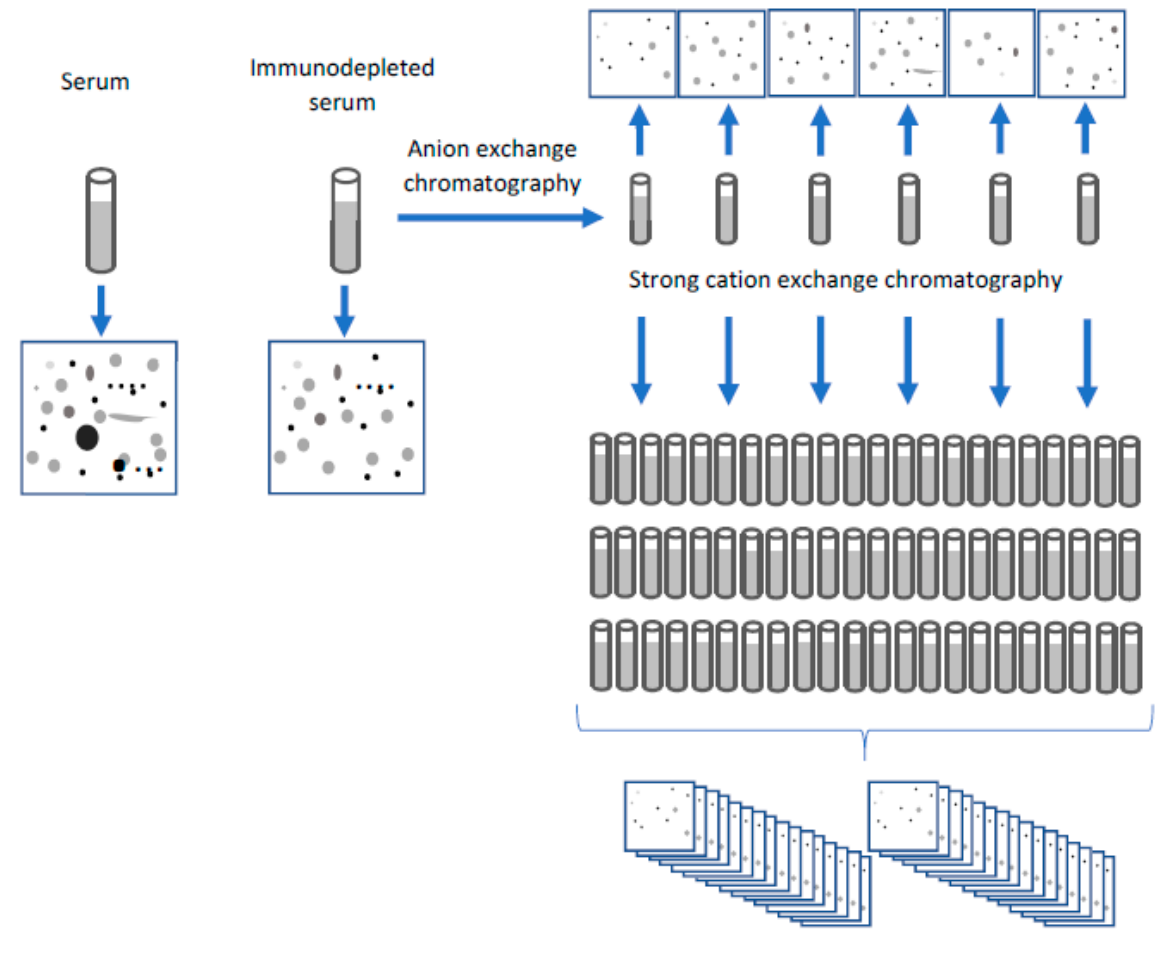
Figure 2. Serum proteome analysis using a combined immunodepletion, liquid chromatographic, and two-dimensional polyacrylamide gel electrophoresis (2D-PAGE) strategy. In the first stage of this strategy, high-abundance proteins were immunodepleted from a serum sample that was then fractionated into six aliquots using anion exchange chromatography. These six aliquots were subsequently fractionated into a total of 66 aliquots using strong cation exchange chromatography. Each aliquot throughout the process was fractionated using 2D-PAGE. Visualized spots within the gel were identified using mass spectrometry. Adapted from [36].